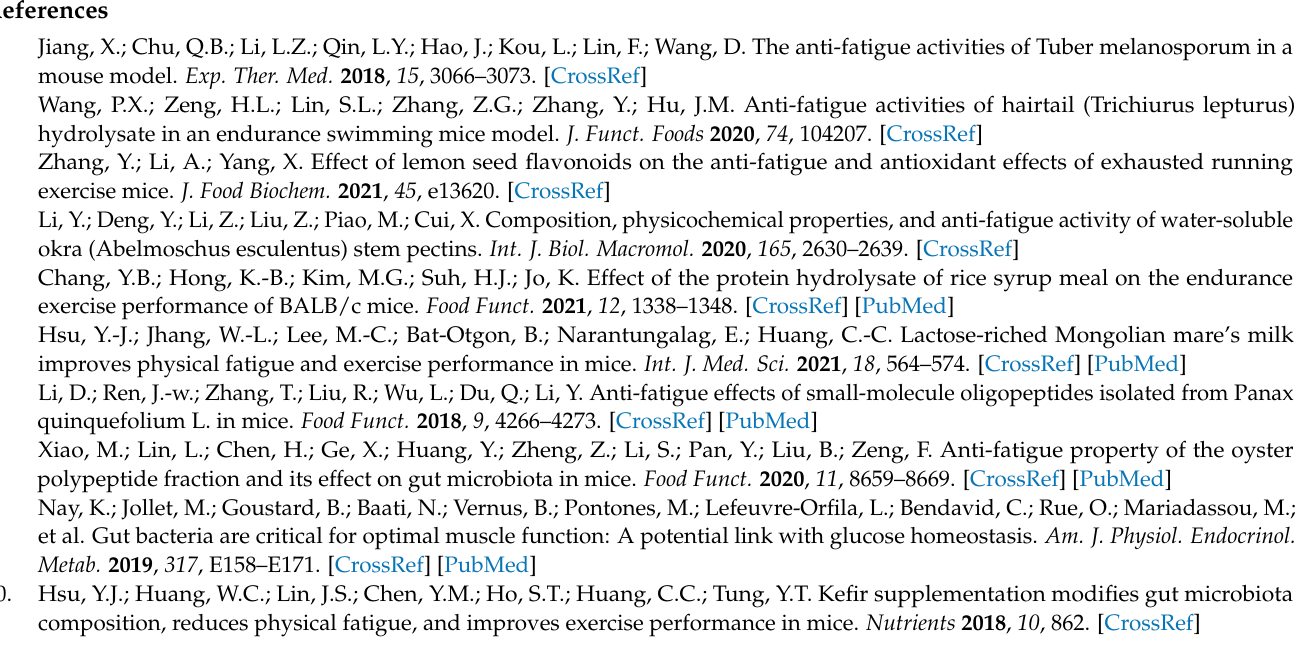
genus.; Table S1: Body and organ weight of